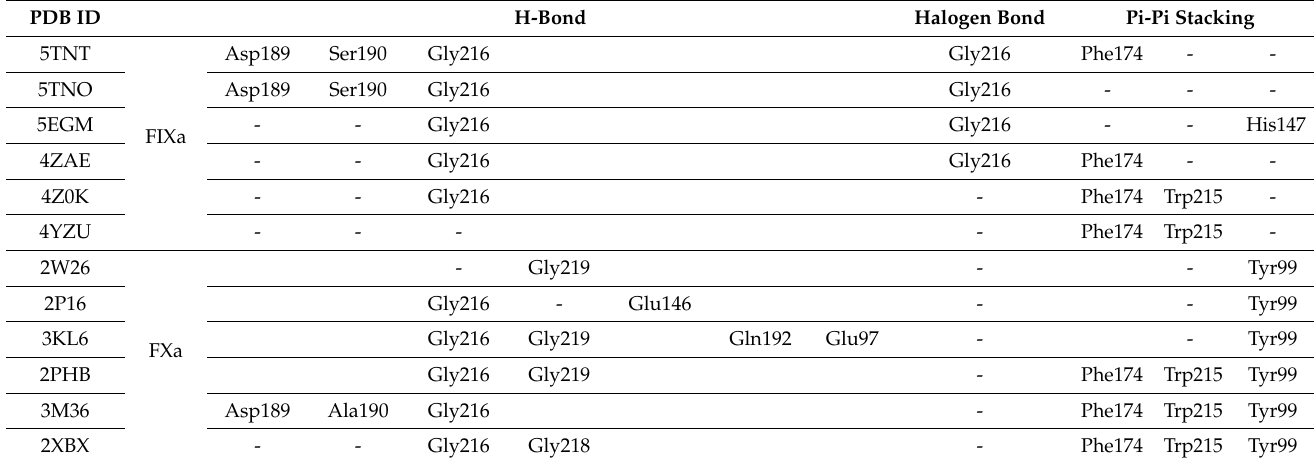
Figure 4. Protein–ligand interaction diagrams (LID) are shown here for all the FXa co-crystal ligands within 4 Å distance: ( a ) for 2W26, ( b ) for 2P16, ( c ) for 3KL6, ( d ) for 2PHB, ( e ) for 3M36 and ( f ) for 2XBX. Table 1. The list of interactions in the two sets of